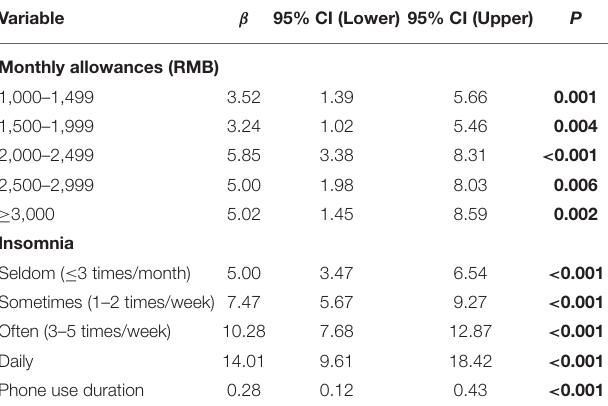
TABLE 5 | Independent correlates of